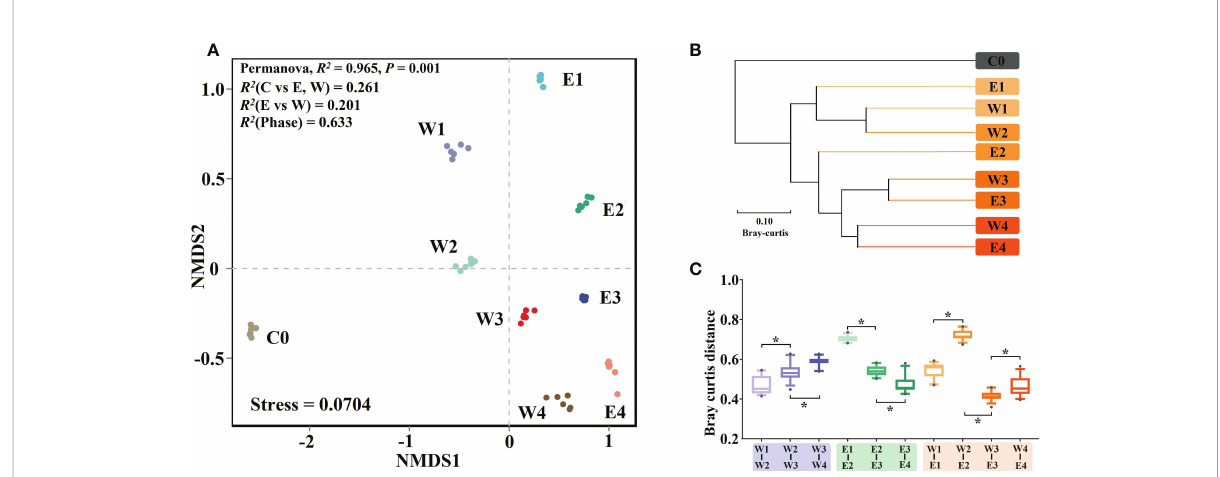
FIGURE 5 Variation in bacterial community structure. (A) The NMDS analysis. (B) The UPGMA analysis. (C) Bray – Curtis distances of pairwise bacterial communities. E and W refer to epiphytic and phycospheric seawater bacterial sample groups, respectively. The numbers 1 to 4 refer to P1 to P4 phases, respectively. C0 refers to the control seawater bacterial sample groups. The asterisks indicate statistical signi fi cance (Student t text, P < 0.05). The error bars represent the standard